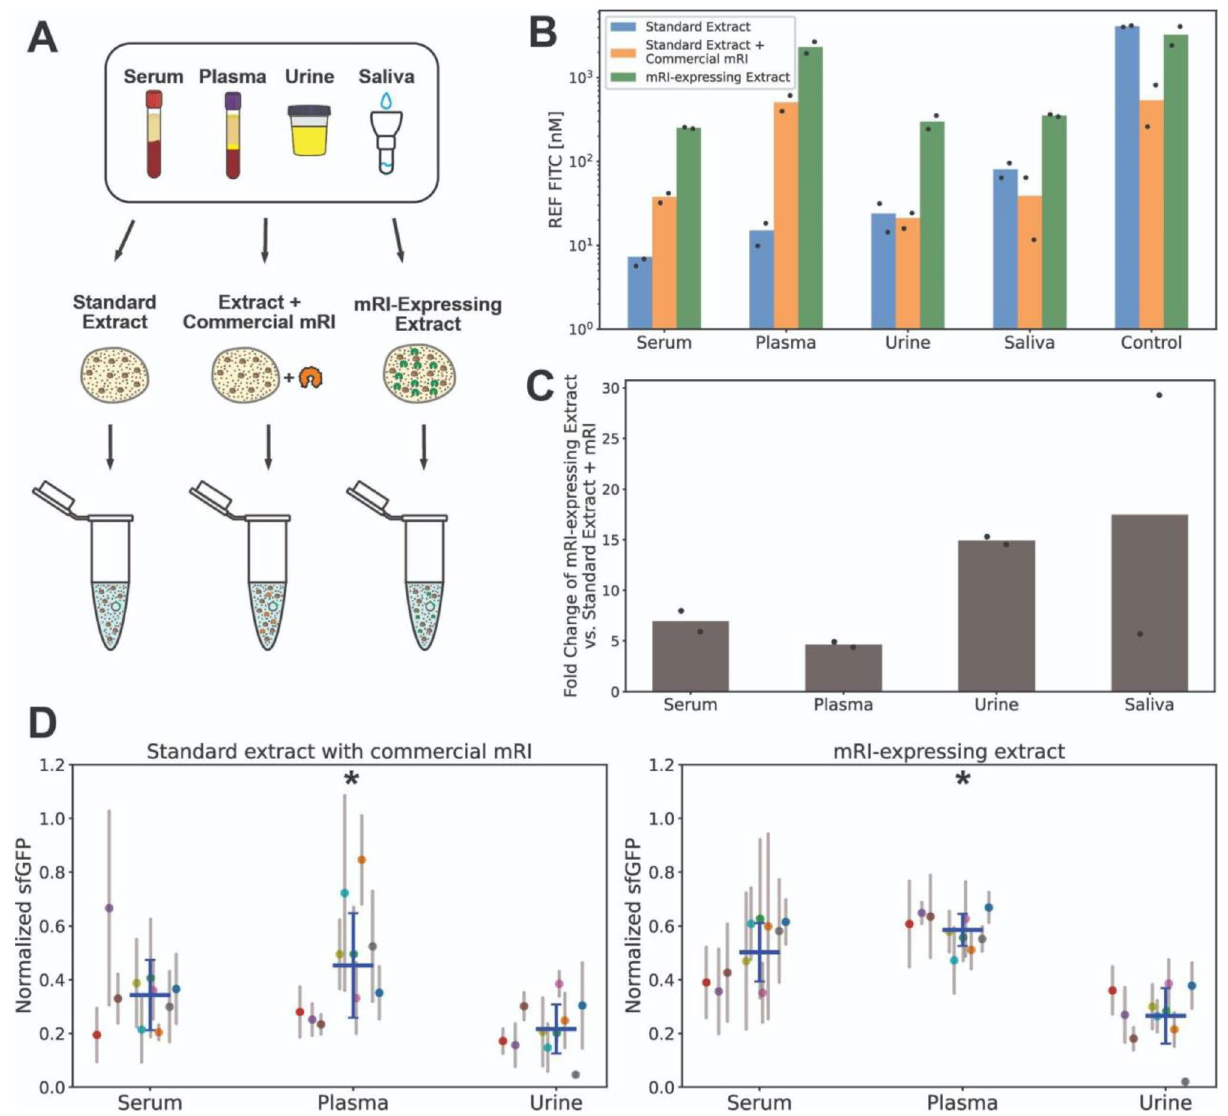
Figure 3. mRI-expressing extract yields larger protein production and moderates interpatient matrix effects. ( A ) Clinical samples (serum, plasma, urine) were mixed with buffer, 10 nM sfGFP DNA, and one of three E. coli extract conditions: standard extract, standard extract with commercial mRI, or mRI-expressing extract. ( B ) Quantification of the matrix effects for each sample. Fluorescence intensity was normalized to the equivalent concentration of FITC (nM). ( C ) Fold change in sfGFP production of mRI-expressing vs. standard extract with commercial mRI. Each clinical sample is a pool of three different individuals. Data are the mean of two experiments performed on two different days. ( D ) Individual patients’ sfGFP production for each clinical sample. Samples from ten patients were measured independently on three different days. Colored solid dots and thin gray lines indicate the mean and SD for each patient. Solid blue lines indicate the mean and SD for the population. An asterisk indicates a p-value from an F-test of variance less than